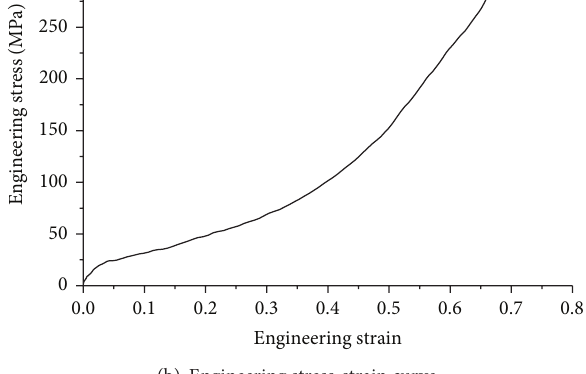
(b) Engineering stress-strain curve Figure 2: SHPB test results of high damping rubber.